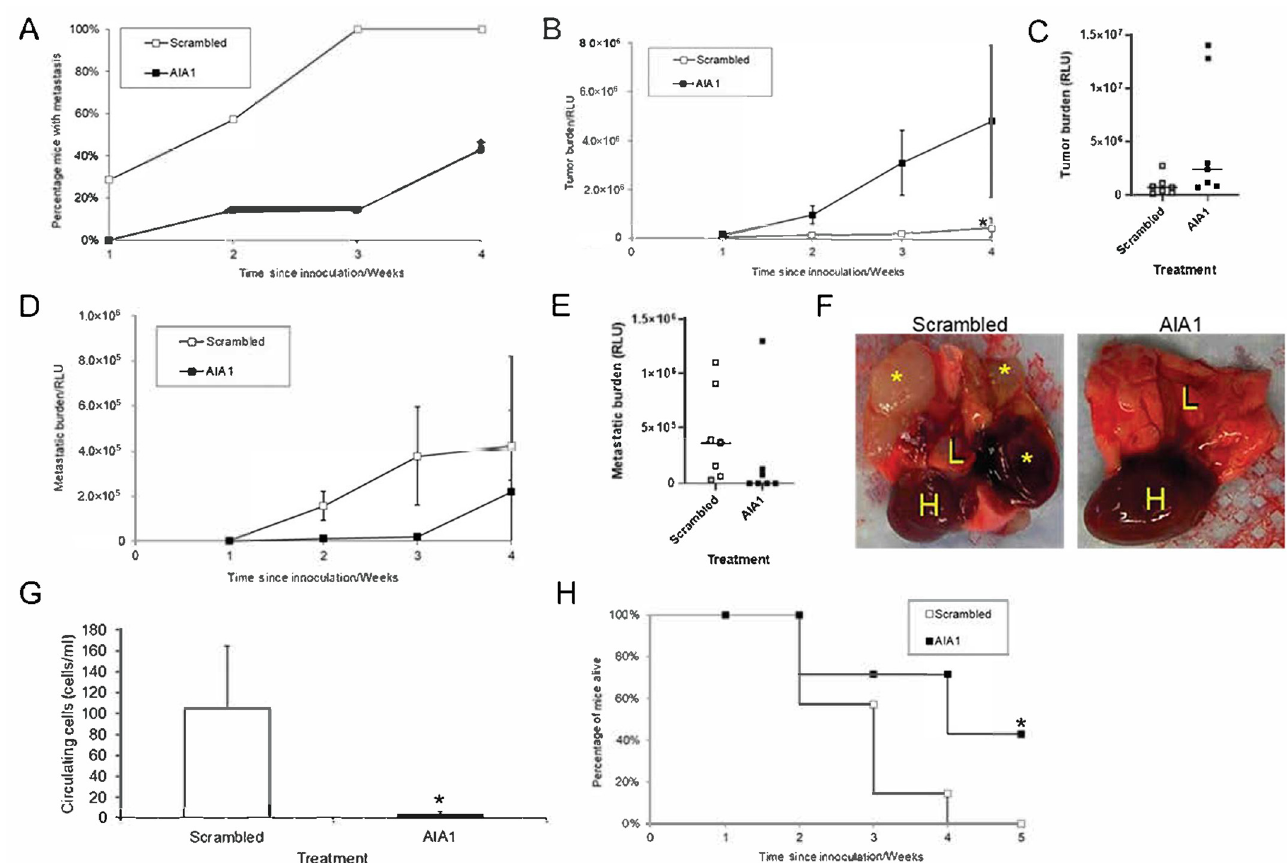
Figure 6. Effect of anti-invasive aptamer AIA1 in a murine model of metastatic osteosarcoma. Osteosarcoma cells (82L cell line) were injected into the right tibiae of male nude mice (5 × 10 5 cells per injection). At the time of tumor injection, AIA1 or control scrambled aptamers were initiated IP daily for 7 days. Primary and lung metastatic tumor burden was measured using bioluminescent imaging (BLI) weekly. ( A ) Percent of mice with BLI-detectable tumors over time. * p < 0.05. ( B ) Total tumor burden per group as measured using BLI. * p < 0.05. ( C ) Tumor burden at week 4 post-tumor inoculation based on BLI. Individual animals’ RLU expression are indicated. ( D ) Total metastatic tumor burden per group as measured using BLI. ( E ) Total metastatic burden at week 4 post-tumor inoculation based on BLI. Individual animals’ RLU expression are indicated. ( F ) Lung and heart of mice that had orthotopic implants of 82L and received scrambled aptamer or AIA1. H = heart; L = lung; * = macrometastasis. Note that in the treatment with a scrambled control aptamer the lung tissue is replaced by metastatic nodules some of which are tan and another is hemorrhagic (dark red). In the AIA1-treated group, the lung appears normal. ( G ) Whole blood was obtained at week 1 post-inoculation of tumor at the time of the last aptamer injection to identify circulating tumor cells using a PCR assay. Circulating cells/mL of blood are reported. * p < 0.05. ( H ) Survival following intratibial injection with tumor cells. All results were reported as mean ± SD. * p < 0.05.